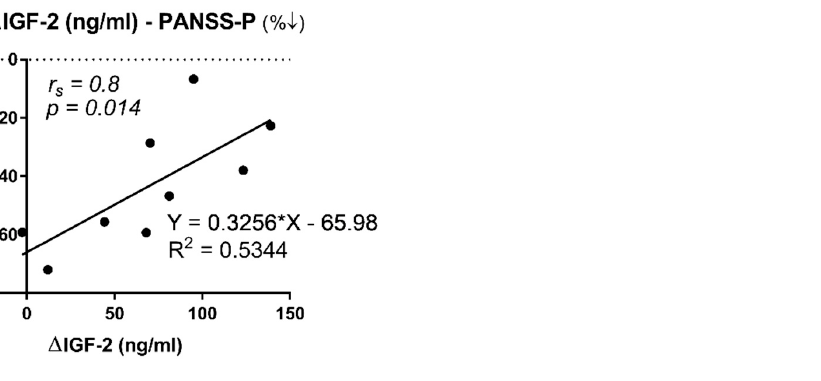
Figure 4. Correlation between ∆ IGF-2 circulating levels and PANSS-P percentage reduction in first episode, drug-naïve patients before and after treatment with atypical antipsychotics (aripiprazole, olanzapine, and risperidone). ∆ IGF-2 (ng/mL): paired protein difference between FE_1 and FE ( ∆ FE = FE_1–FE), PANSS-P (% ↓ ): indicates PANSS percentage reduction calculated as (FE_1–FE)/FE × 100. (r s ) indicates Spearman’s correlation coefficient and p -value is given. Trend line calculated by linear regression analysis and the correspondent R-squared (R 2 ) is shown.